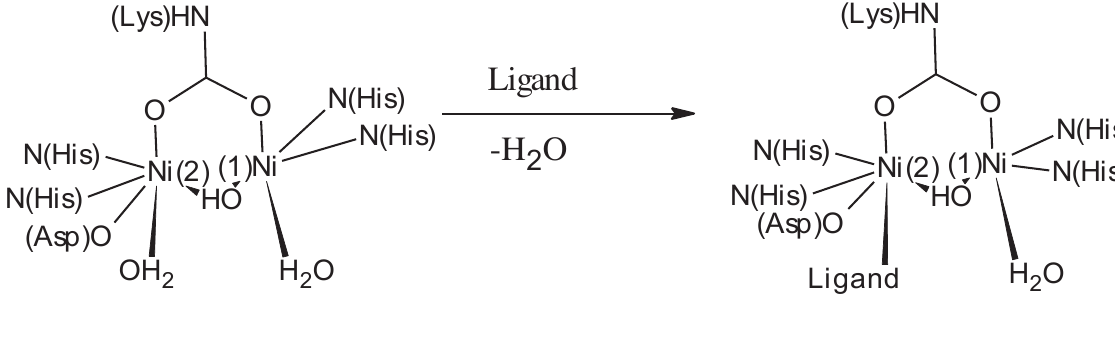
Scheme 2: Mechanism of interaction of inhibitors with urease. List of Figures: